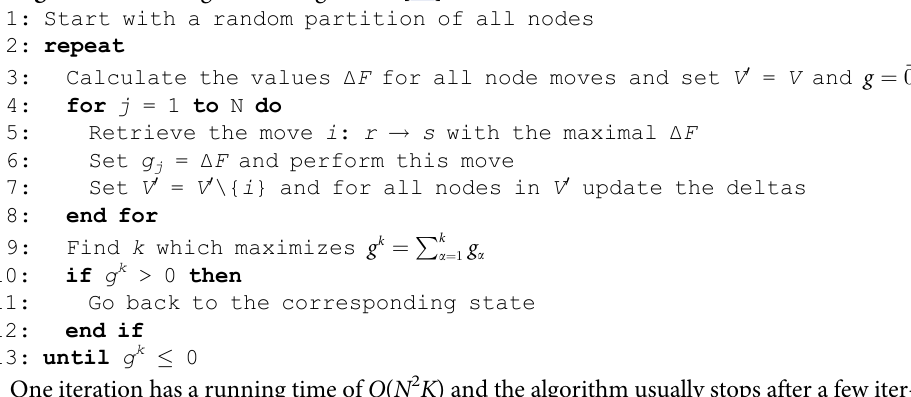
Algorithm 3 Kernighan-Lin algorithm